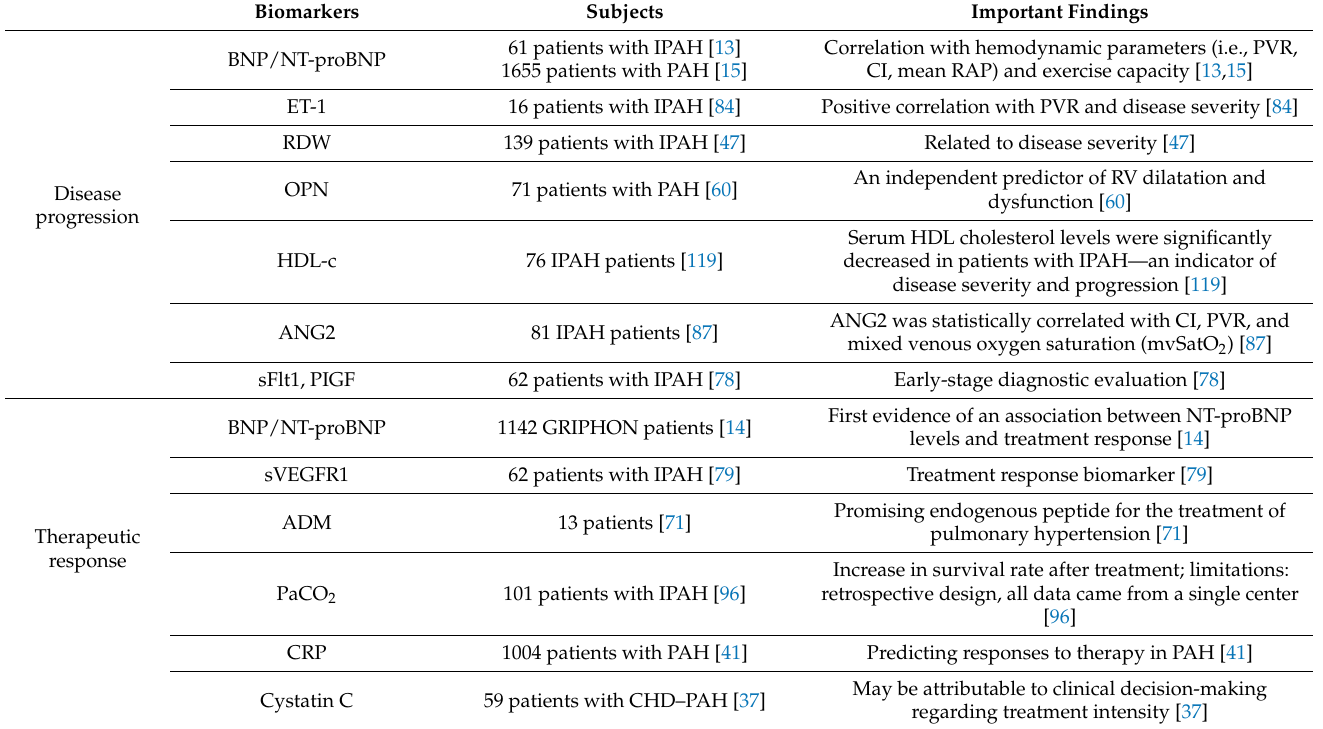
Table 2. How to use biomarkers in the clinical management of PAH: an extended table showing different biomarkers discussed in this